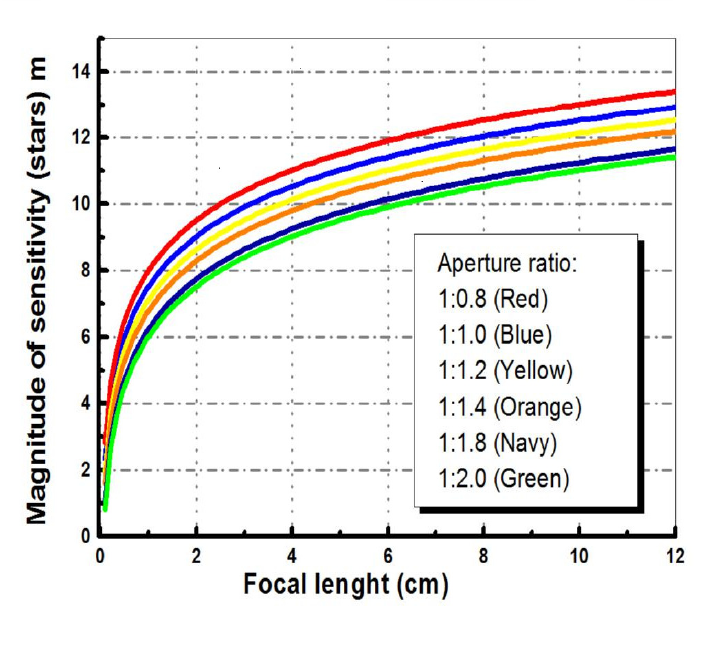
Fig. 1 The extreme sensitivity of the Watec CCD (stars) with afrequency 25 frame/sec and lenses with different